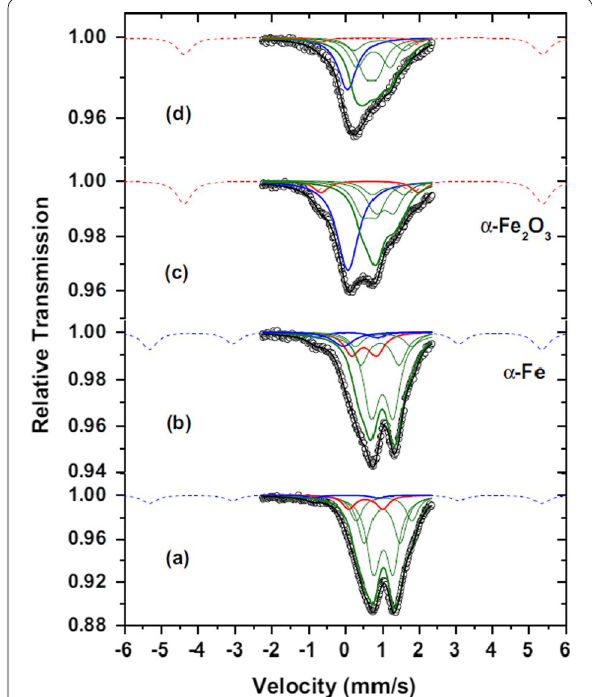
Fig. 3 Comparison of 57 Fe Mössbauer spectra at 300 K of the pristine Fe 1 O material ( a ), after an uptake of 1 Li ( b ) and the end − x for discharge at 2.16 Li ( c ). Green contributions are attributed to FeII. The thicker green line is sum of the thinner one corresponding to unreacted Fe 1 O. Dashed blue line corresponds to the expected − x increasing contribution of α-Fe from ( a ) to ( c ). In the case of ( c ), magnetic sextet has been slightly shifted as a guide of the eye. Spectrum ( d ) corresponds to the end of the first charge at 0.94 Li with no α-Fe contribution, but the blue singlet nanosized metallic ε-Fe 0 is still present. Reprinted with Permission from [42]. Copyright, Elsevier Masson